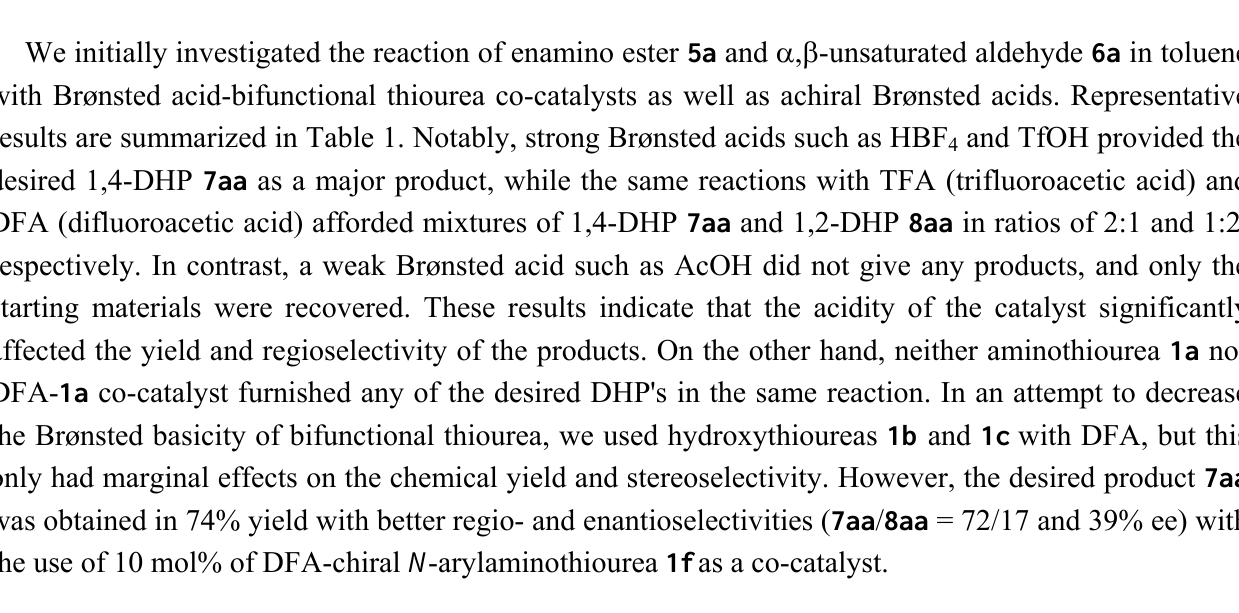
Table 1. Initial screening of various catalysts for the synthesis of 1,4-DHP 7aa .